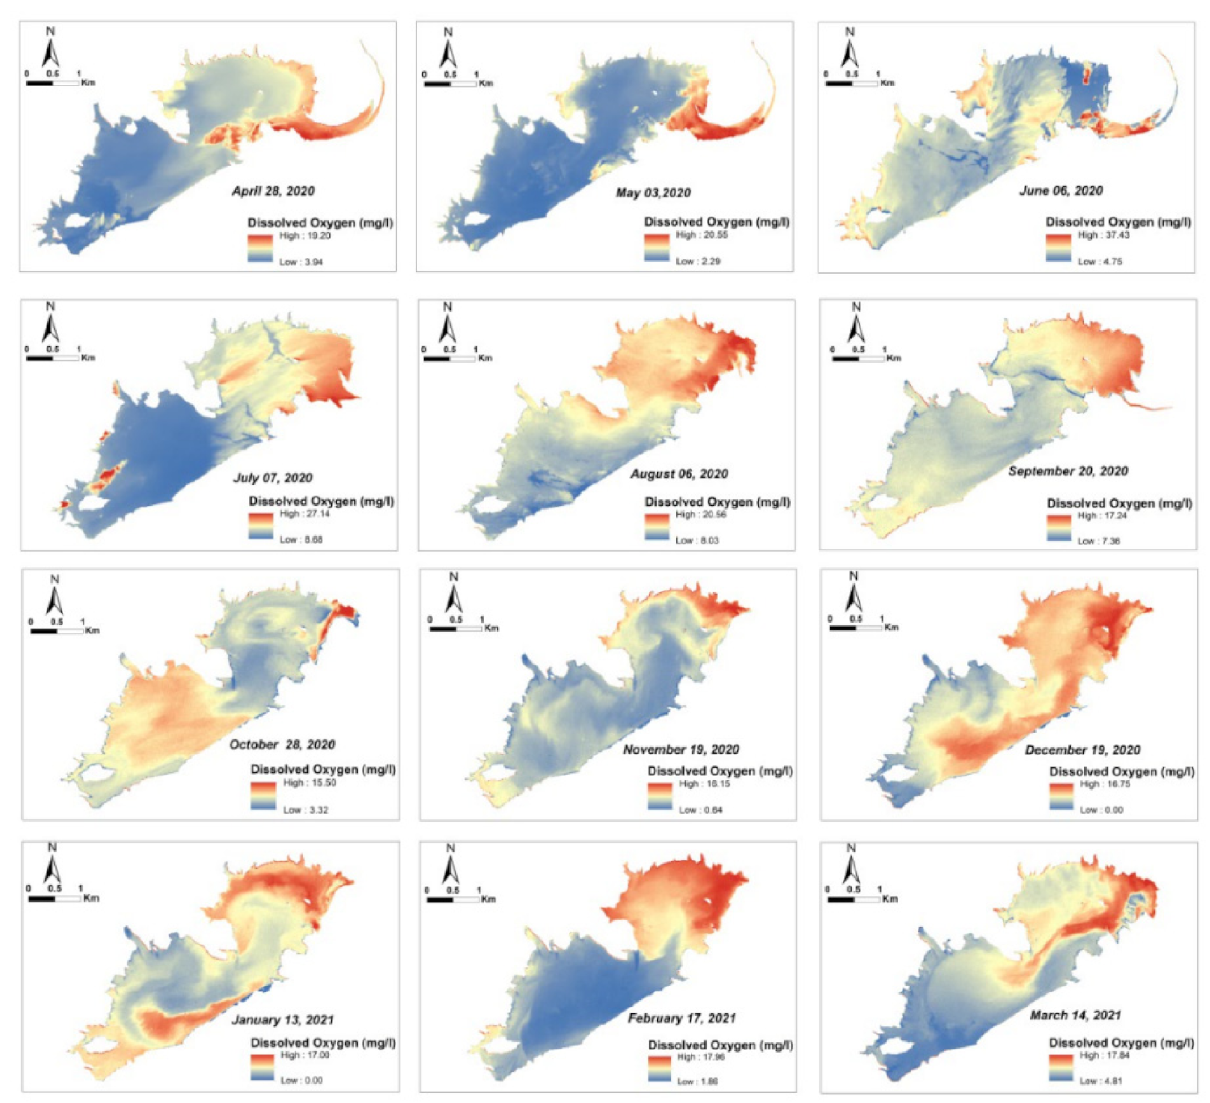
Figure 6. Obtained maps of dissolved oxygen using best